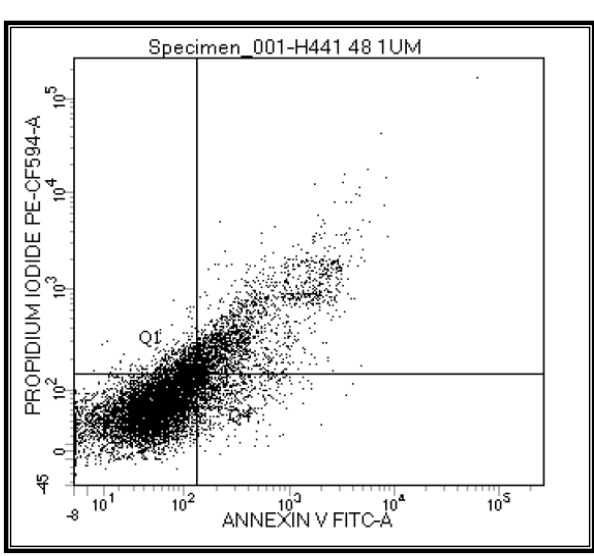
Figure 8 : Apoptosis and necrosis after 48 hr of nicotine treatment with concentration (1 μM) in H441 lung cancer cells by flow